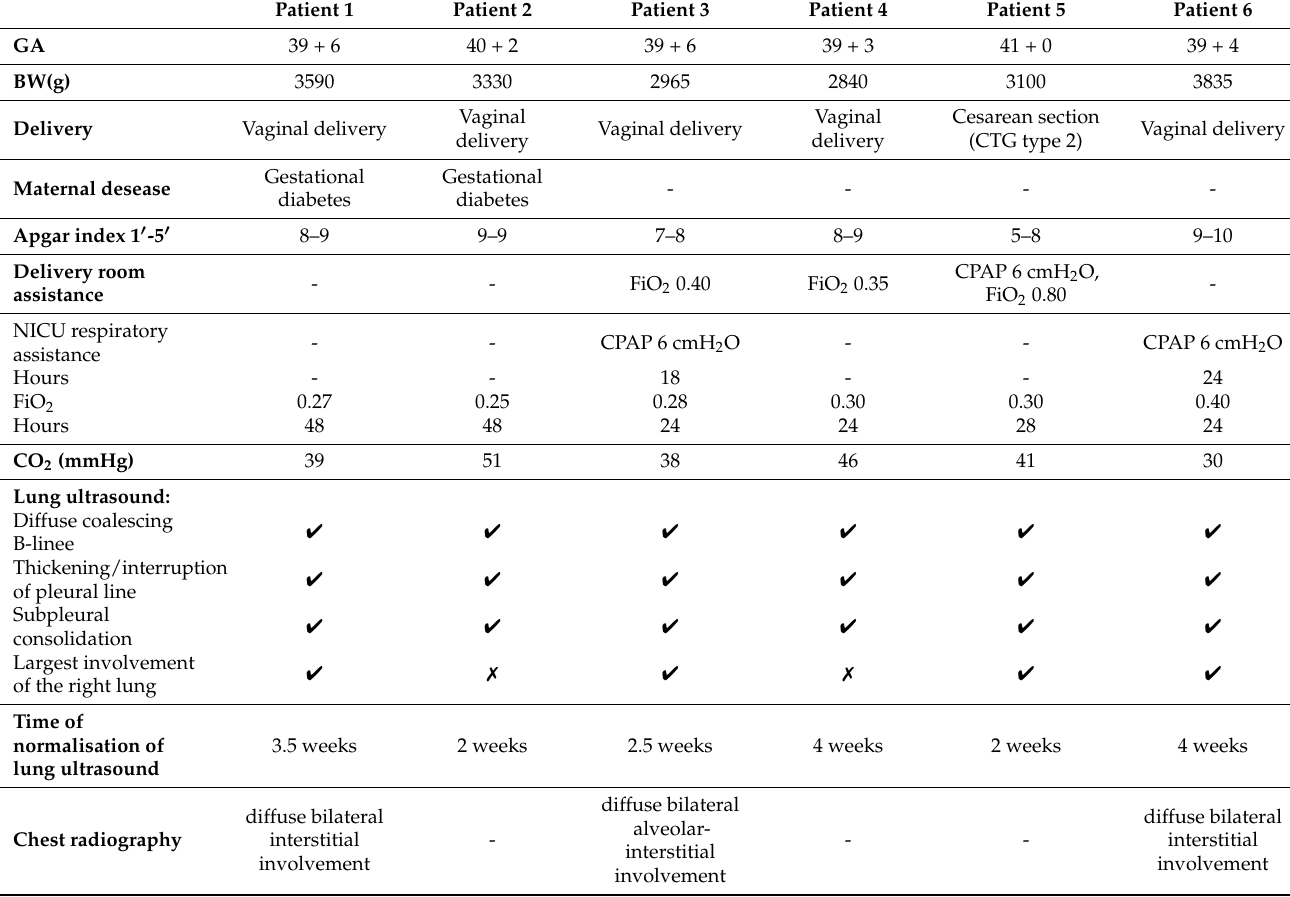
Figure 2. Sub-pleural extended consolidation. This patient has a more severe disease than the one presented in Figure 1. At the top of the image, the right lung is shown, divided into three areas: the upper anterior, lower anterior, and lateral. In the lower portion of the image, the left lung. Data for each infant are shown in Table 1. Table 1. Summary of neonatal characteristics. GA: gestational age. BW: birth weight. CTG: car- diotocography. NICU: neonatal intensive care